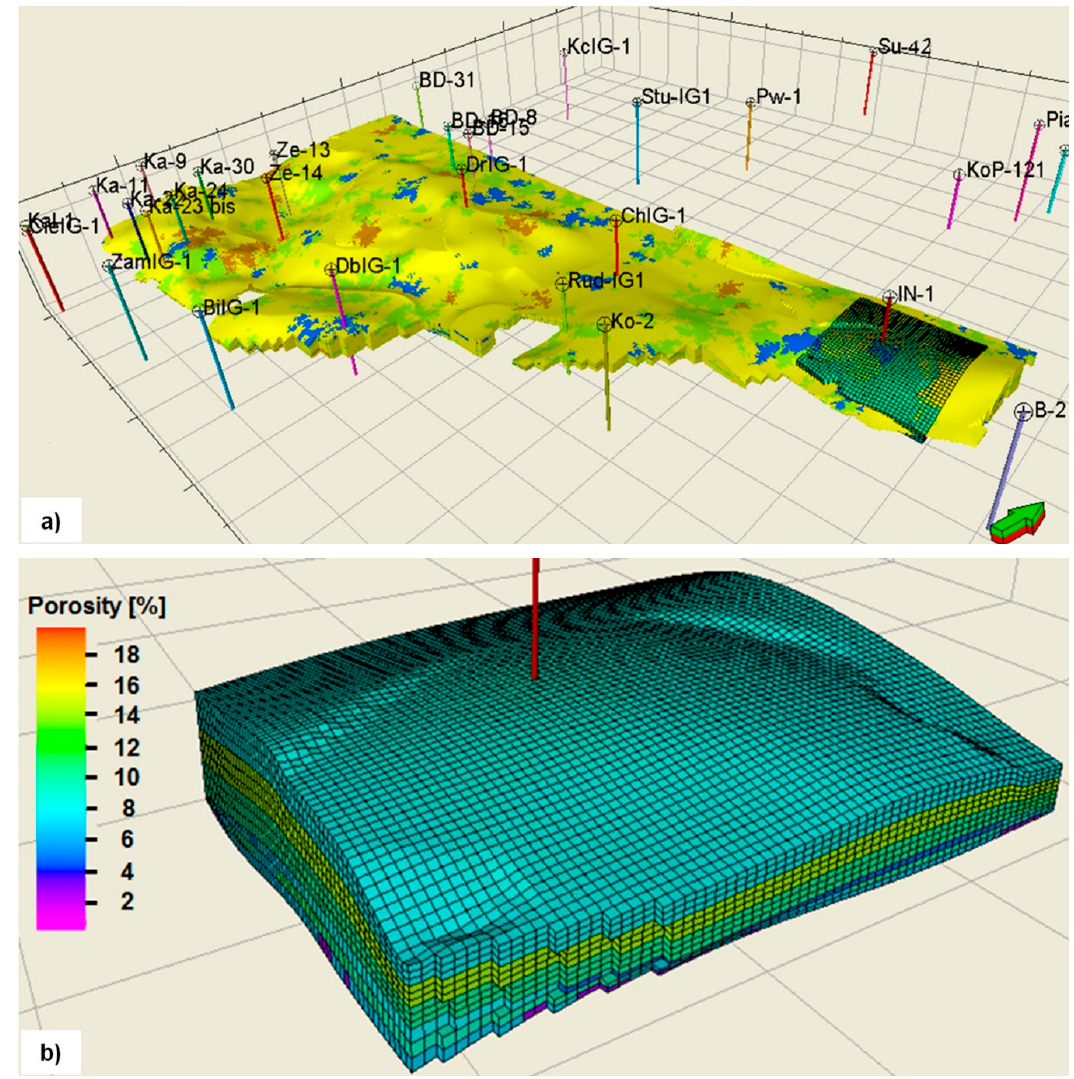
Figure 4. The lithological model within the Upper Silesian Sandstone Series ( a ) with a separate local model, an effective porosity model ( b ), for the purpose of reservoir simulations.